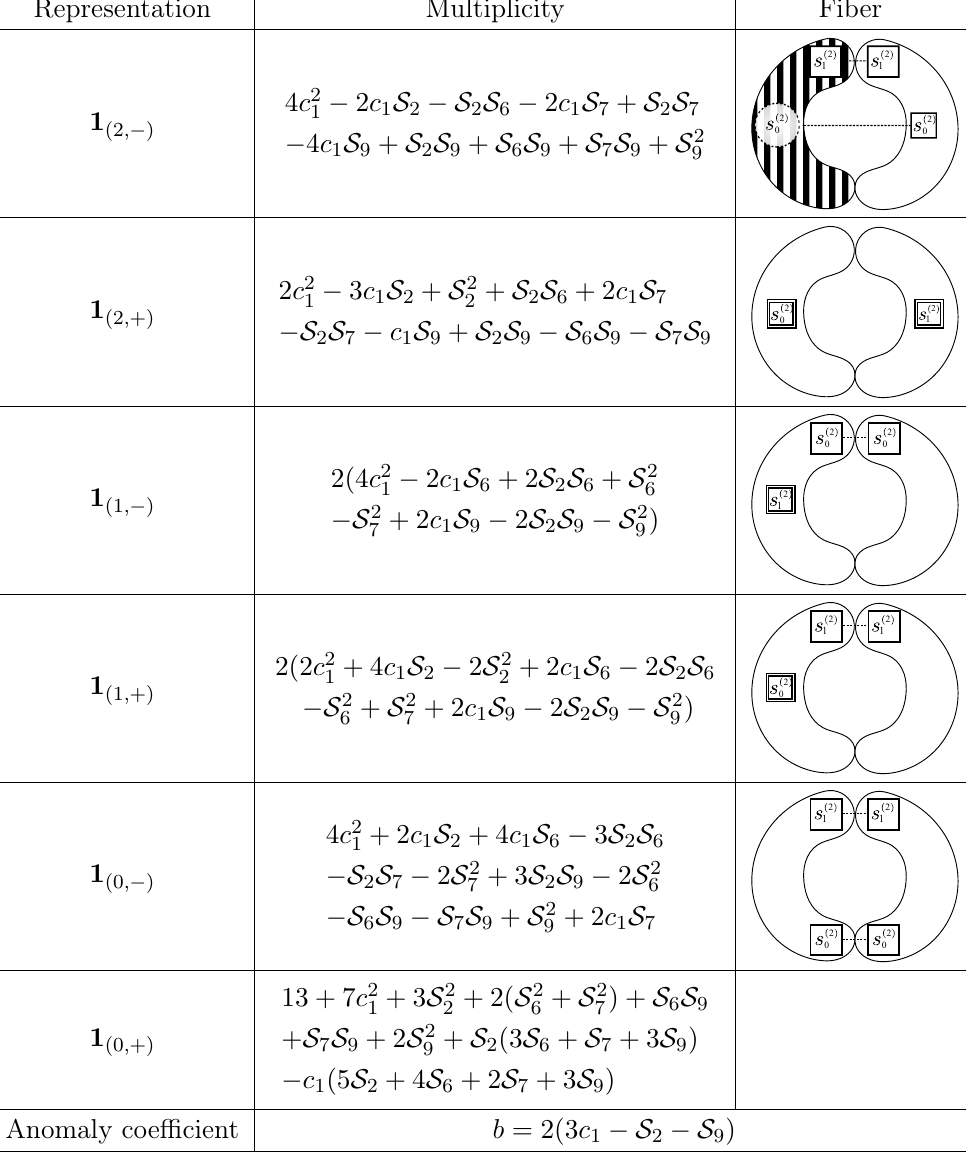
Table 4 . Summary of the charged matter representations and multiplicities under U(1) (cid:2) Z 2 and codimension two fibers of nef (6 ; 1)